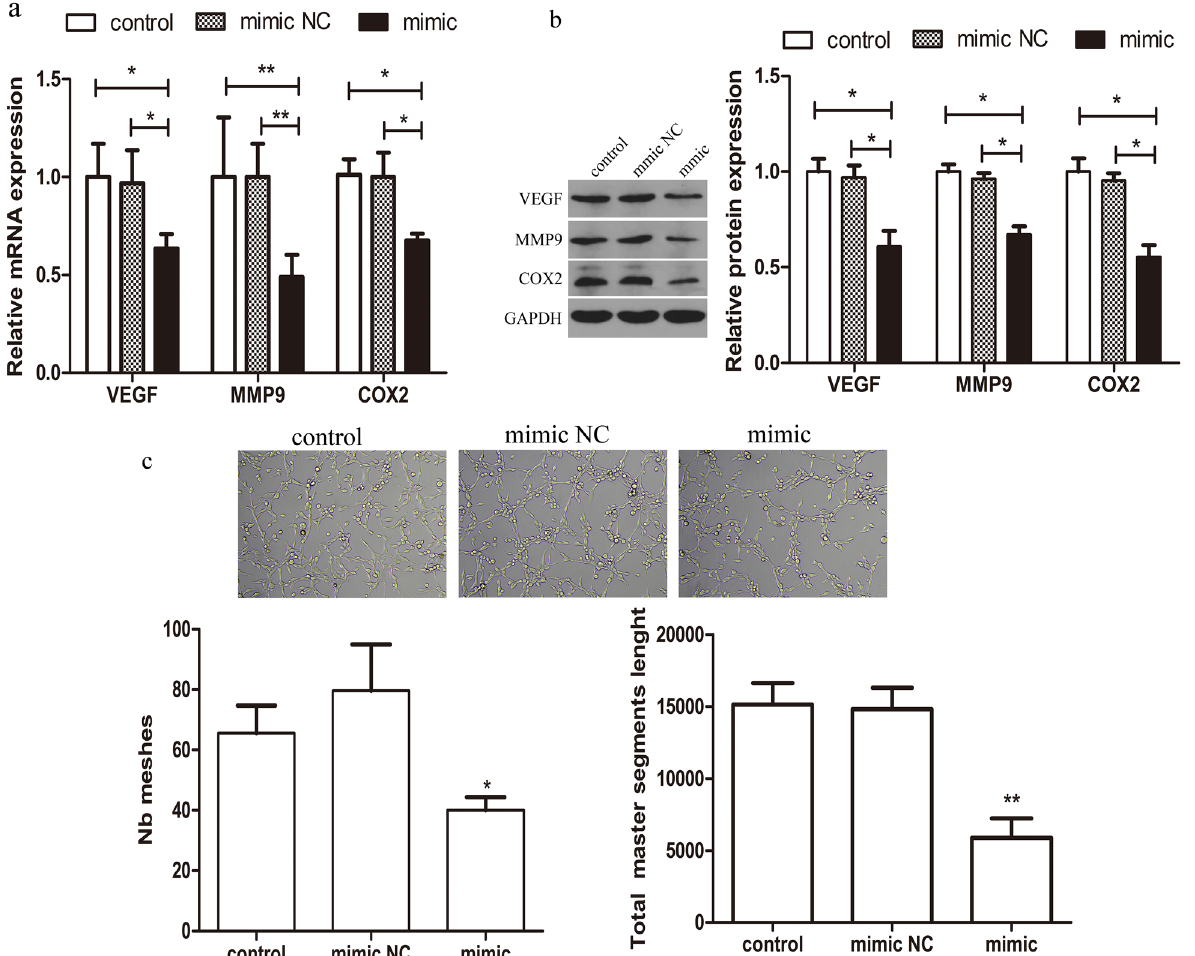
Figure 5. Effect of miR-542-3p overexpression on angiogenetic capacity of HESCs. ( a ) q-PCR analysis of VEGF, MMP9.COX2 mRNA levels in control or miR-542-3p mimic or mimics NC groups. ( b ) Representative western blots showing VEGF, MMP9.COX2 protein levels in control or miR-542-3p mimic or mimics NC groups. ( c ) Capillary-like tube formation performed by HUVECs with /without the supernatant of miR-542-3p- overexpressing HESCs. Representative images (100X) are showed. Number of Tube area (tube meshes and total master segment length) were acquired automatically. *p < 0.05, **p < 0.01. Values are expressed as mean ± SD of three independent